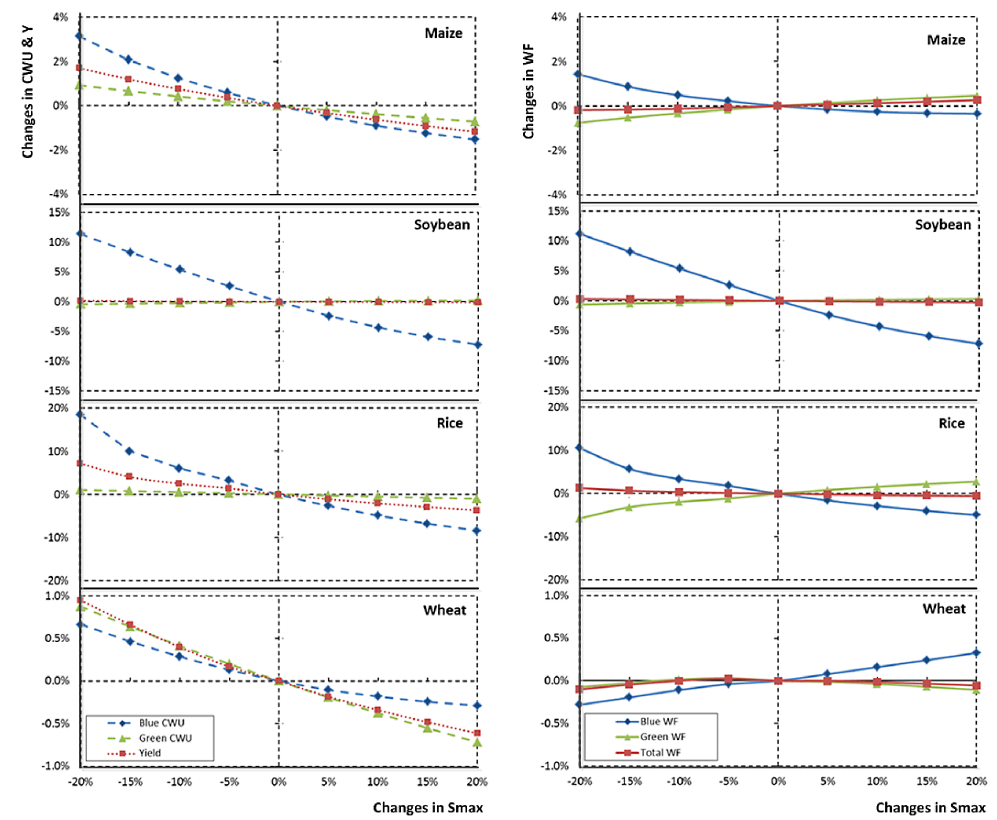
Figure 6. Sensitivity of CWU, Y and WF to changes in the field capacity of the soil water ( S max ),